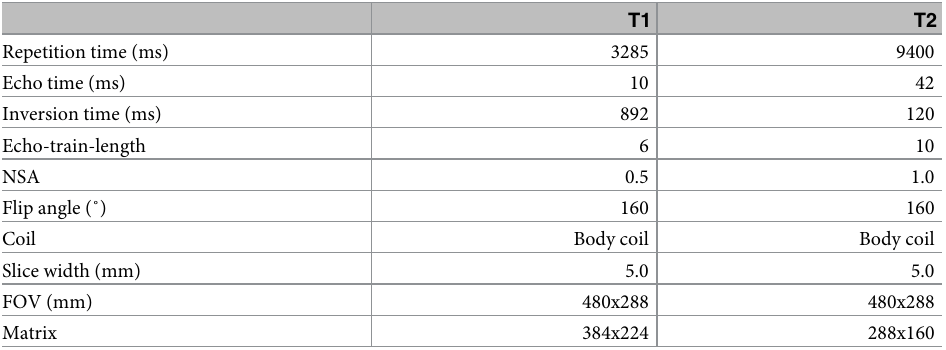
Table 1. Postmortem MRI protocol.